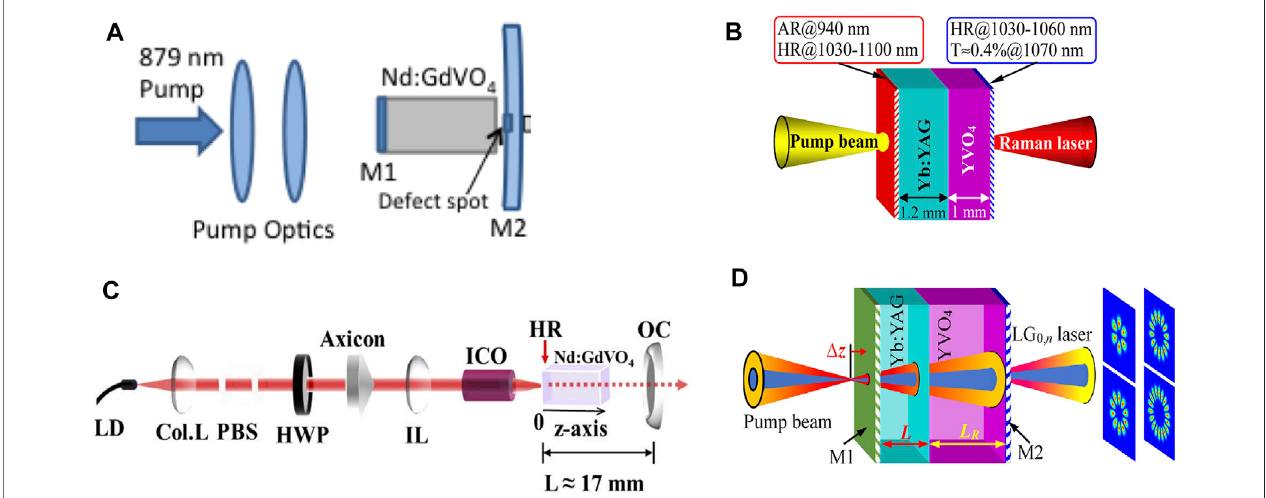
FIGURE6|(A) Nd:GdVO 4 self-Ramanvortexlaserwithdefect spotmirrorfor fi rstStokesoutput [60] (B) Yb:YAG/YVO 4 microchipRamanvortex laserwithoff-axis pumping for the frequency-comb output [122] (C) Nd:GdVO 4 self-Raman vortex laser with annular pumping design by an axicon for multi-Stokes output [123] (D) microchip Raman vortex laser based on annular pumping for LG 0,n petal-mode generation [124].